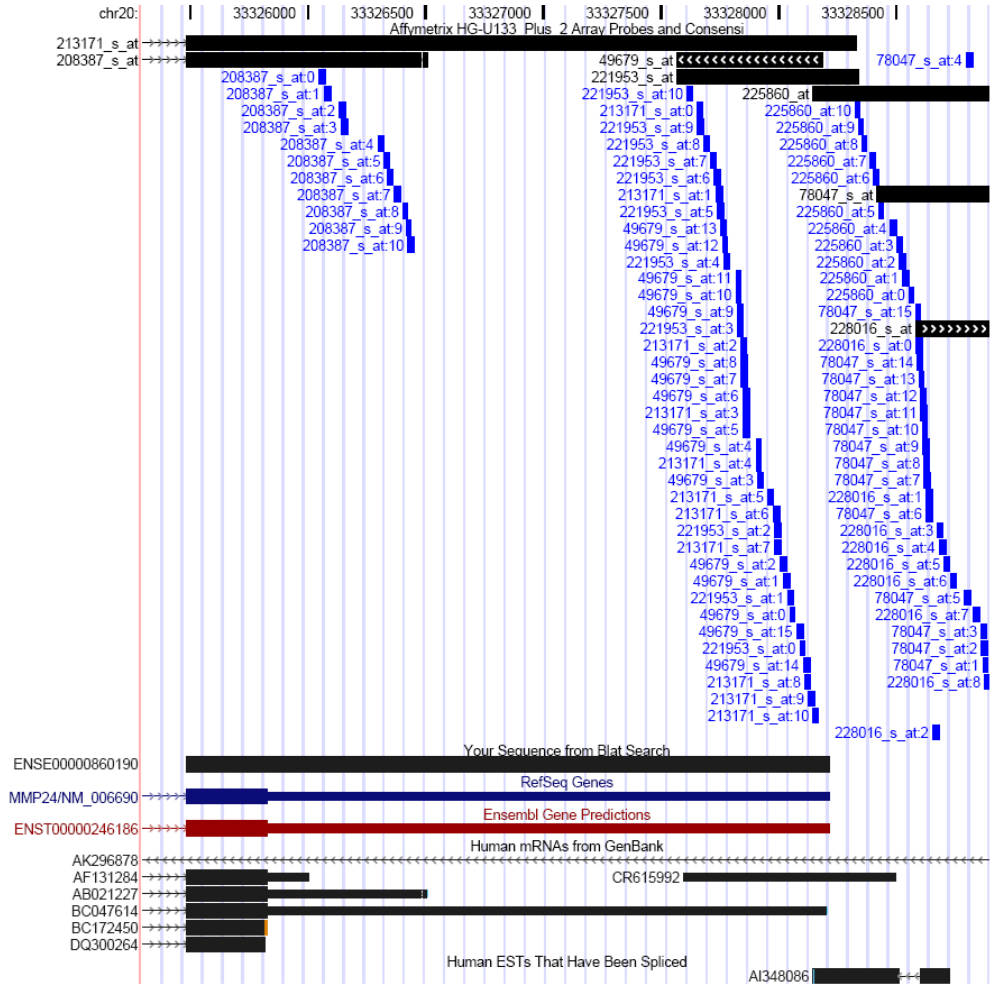
Figure S2. UCSC screen shot for